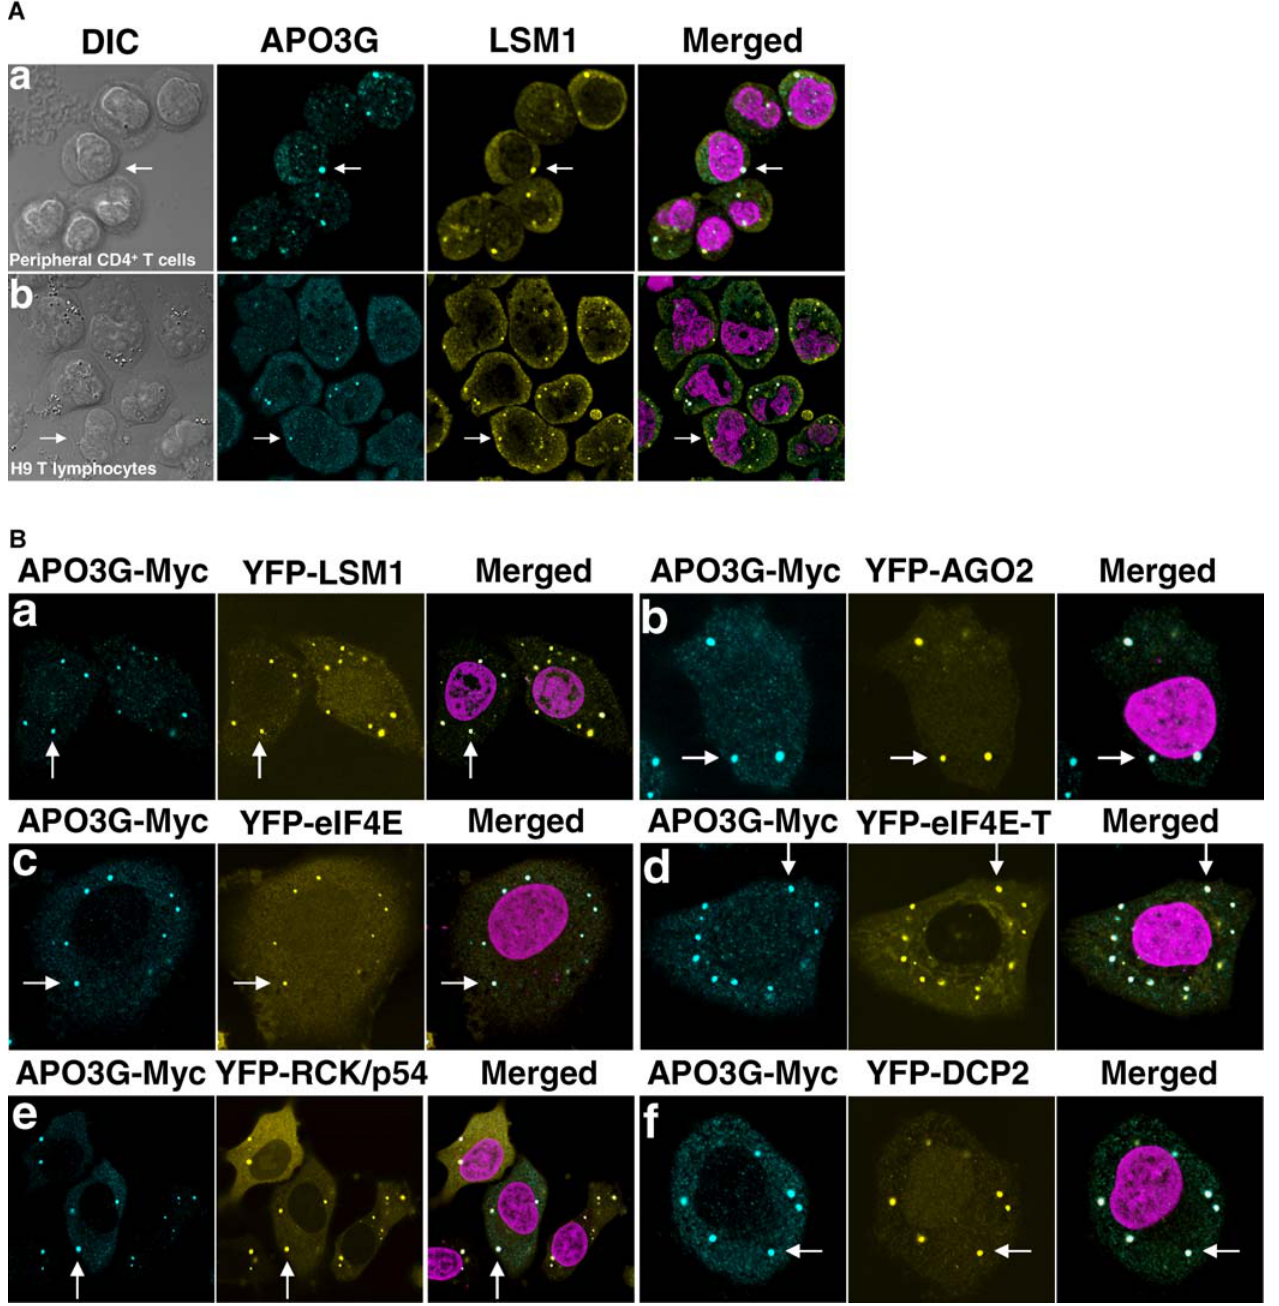
Figure 2. APOBEC3G Cytoplasmic Bodies Are P-Bodies (A) Subcellular localization of APOBEC3G and LSM1 in T cells. Endogenous APOBEC3G and LSM1 were localized in peripheral blood CD4 þ T cells (a) and H9 T lymphocytes (b) through indirect immunostaining using antibodies against APOBEC3G and LSM1, respectively. The cells were counterstained with Hoechst 33258 to visualize nuclei and the images were digitally merged to highlight regions of colocalization, which appear white in the merged images. A corresponding differential interference contrast (DIC) image is presented to the left and arrows point to cytoplasmic bodies. (B) APOBEC3G colocalizes with P-body proteins at P-bodies. Subcellular localization of APO3G-Myc and YFP-LSM1 (a), YFP-AGO2 (b), YFP-eIF4E (c), YFP- eIF4E-T (d), YFP-RCK/p54 (e), or YFP-DCP2 (f) in HeLa-APO3G cells. APO3G-Myc was detected through indirect immunostaining with an antibody against the c-Myc epitope and YFP was detected by direct fluorescence. The cells were counterstained with Hoechst 33258 to visualize nuclei and the images were digitally merged to highlight regions of colocalization, which appear white in the merged images. Arrows point to P-bodies. DOI: